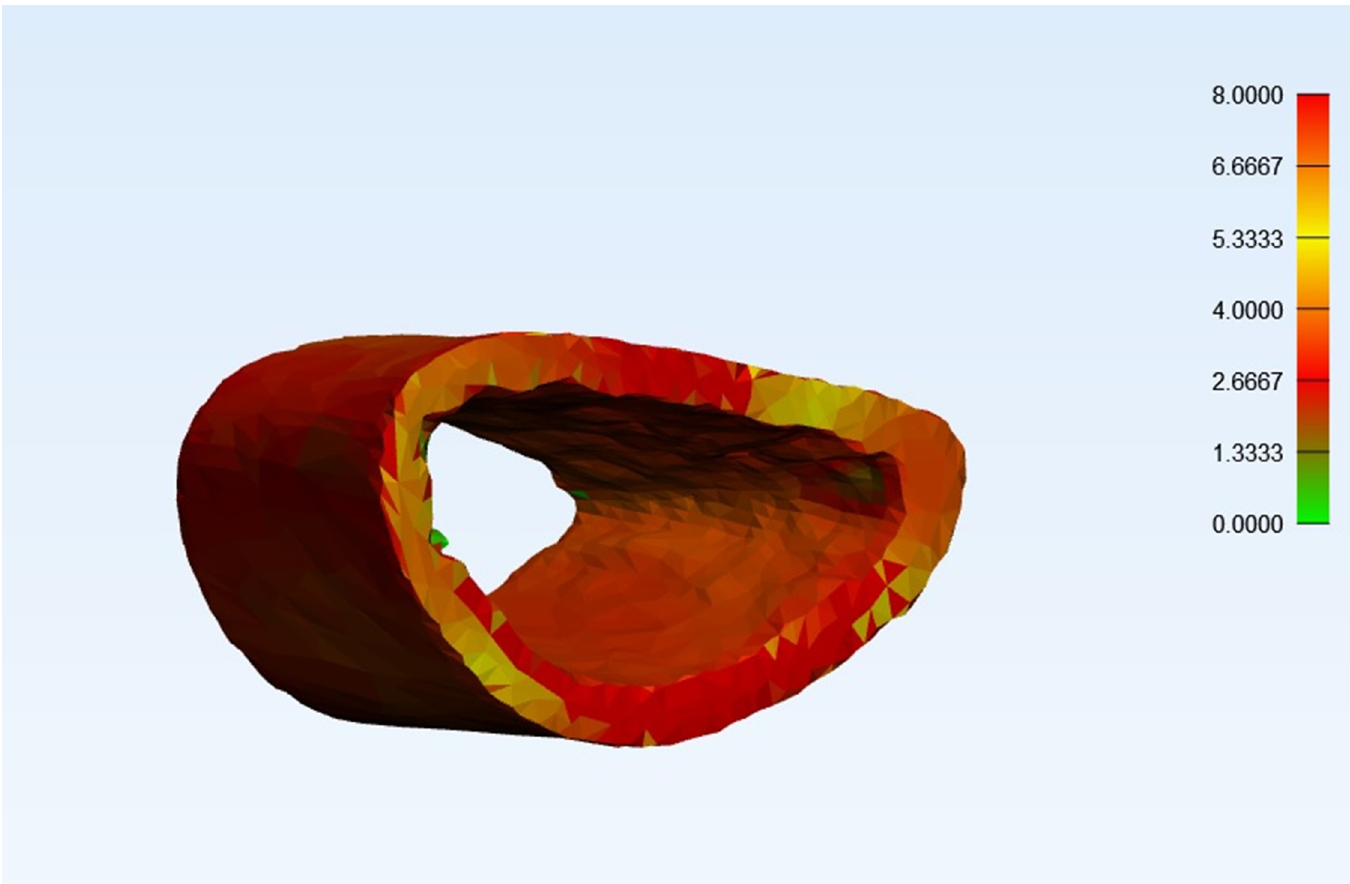
Fig 5. Average cortical thickness calculation. Automatic calculation of the average cortical thickness (Ct of ROI) in the Mimics 1 software.